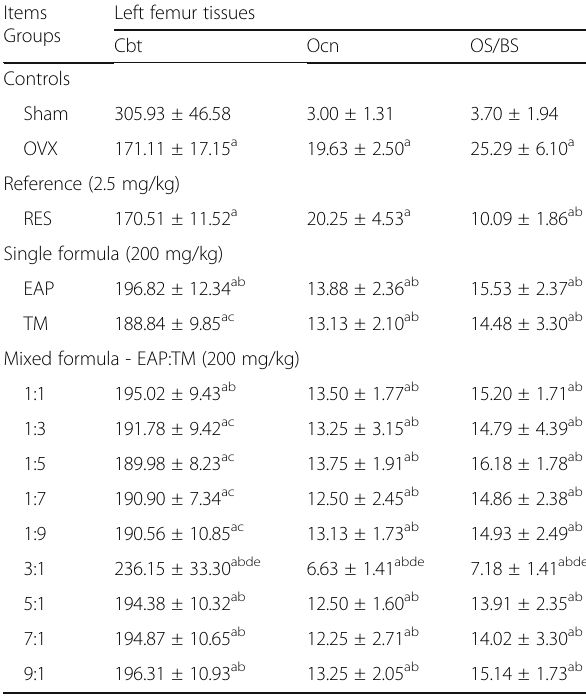
Table 5 Histopathology and histomorphometry of the femur in sham-operated and OVX mice: Cortical Bones and Osteoclast